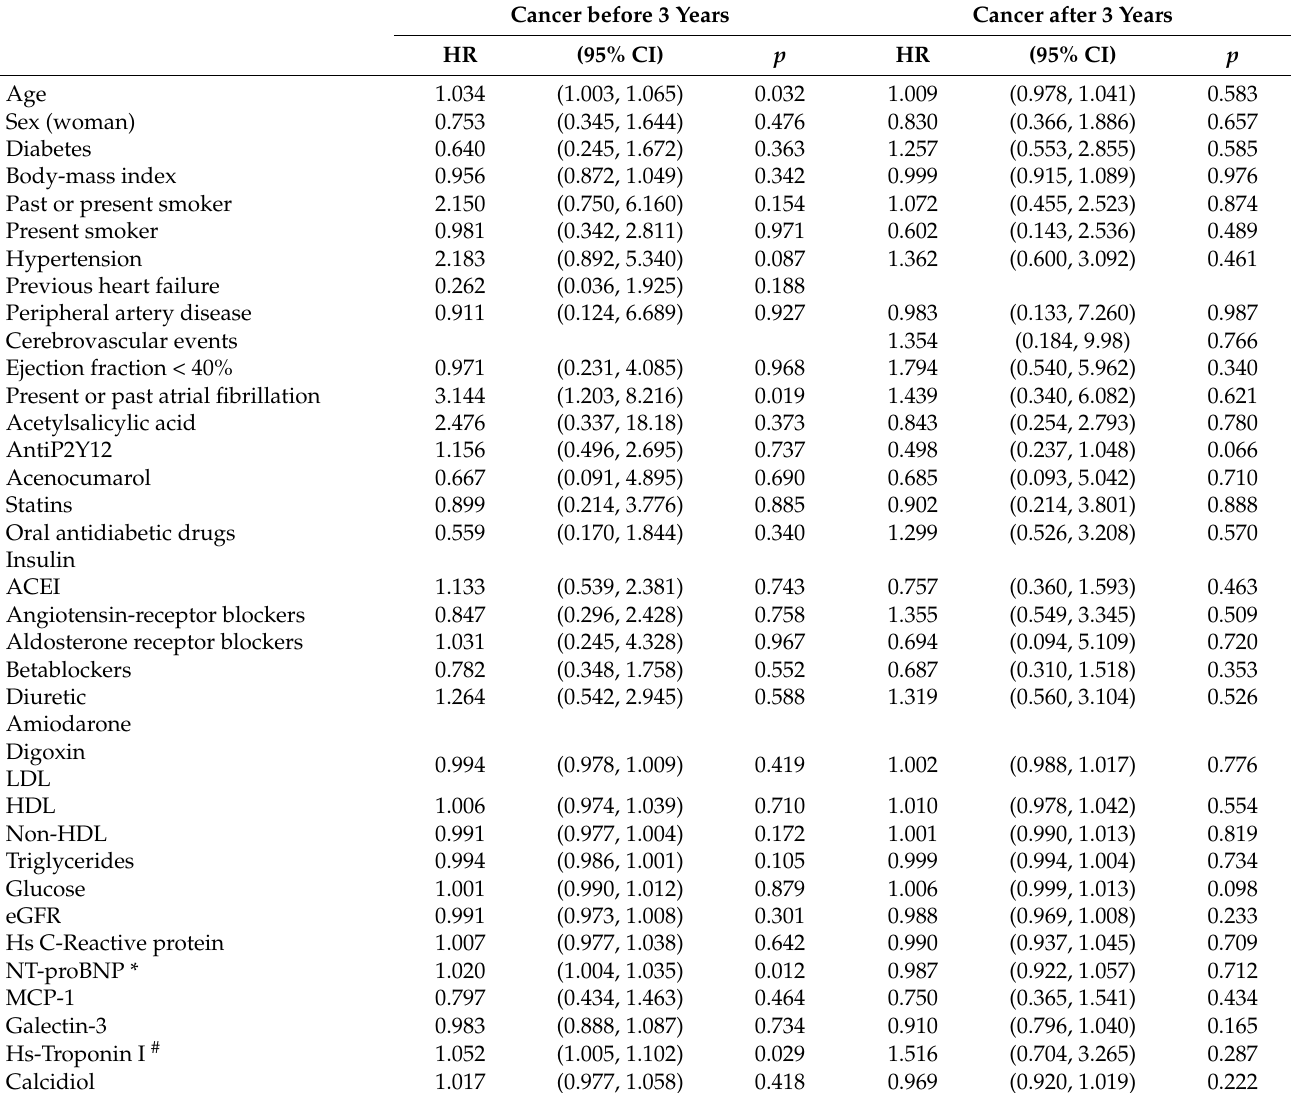
Table 3. Univariate analysis of cancer predictors before and after three years of